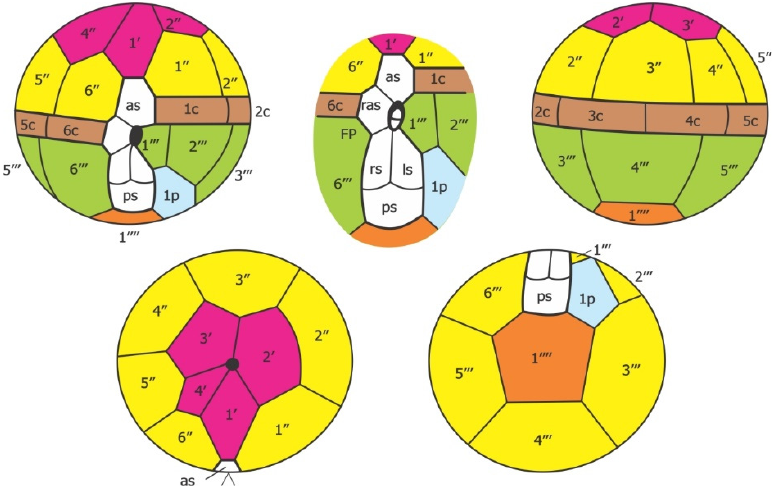
Figure 18. Standard gonyaulacalean tabulation. Top left: ventral view. Top centre: detail of sulcus. Top right: dorsal view. Bottom left: apical (anterior) view. Bottom right: antapical (posterior) view. Note that there are four apical plates (red), six precingular plates (yellow), six cingular plates (brown), six postcingular plates (green), one posterior intercalary plate (plates between postcingular and antapical plates; shown in light blue) and one antapical plate (orange). The basic tabulation